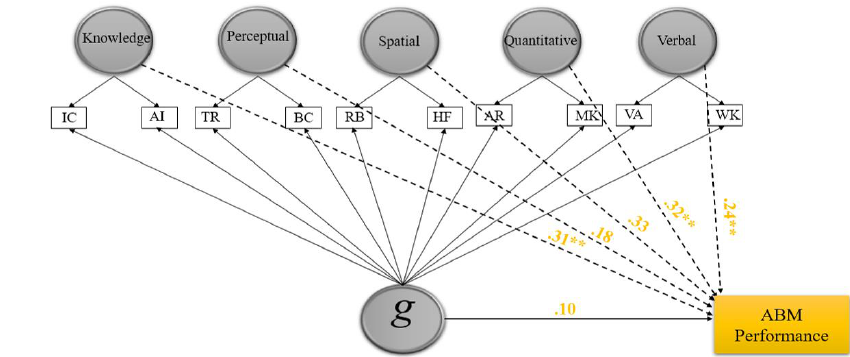
Figure 3. Bifactor SEM model for pilot ( a ), navigator ( b ), and air battle manager ( c ) data and the predictive validity estimates of general ability and specific abilities on job performance. Note: VA = Verbal Analogies; WK = Word Knowledge; AR = Arithmetic Reasoning; MK = Math Knowledge; RB = Rotated Blocks; HF = Hidden Figures; TR = Table Reading; BC = Block Counting; IR = Instrument Comprehension; AI = Aviation Information. Loadings of indicator pairs on their specific factor were constrained to be equal for model identification. Table 5. Prediction of job performance by general ability and specific abilities via bifactor